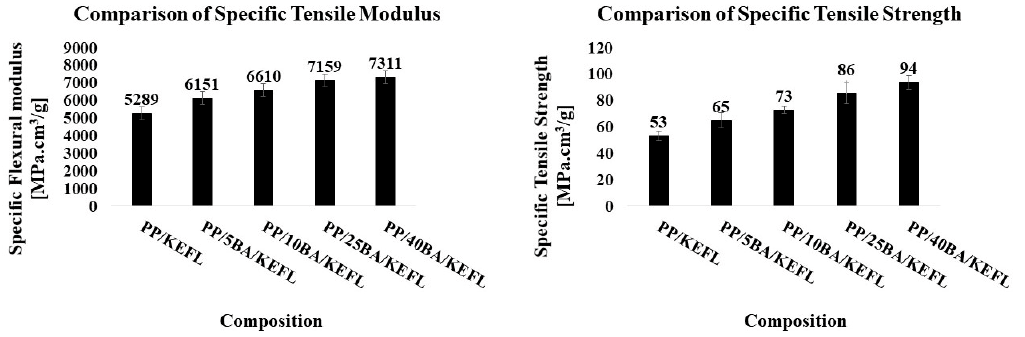
Figure 5. Tensile analysis of PP composites with bast and hybrid bast/BA fibers.